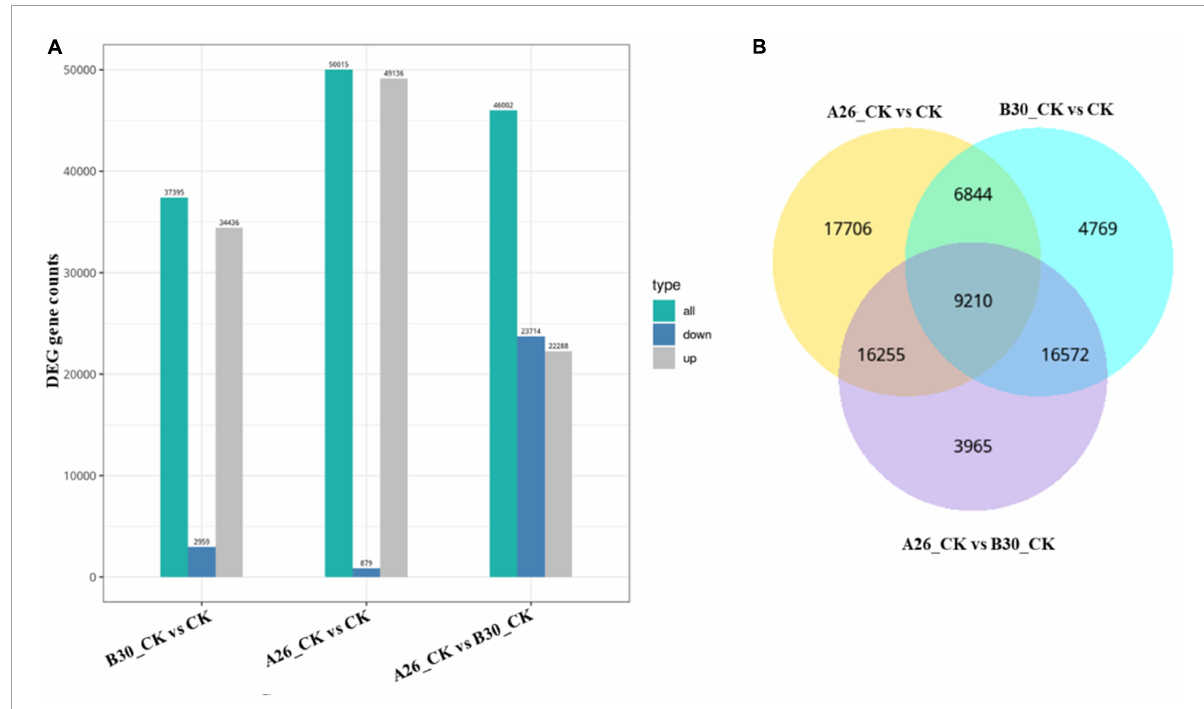
FIGURE9 (A) Bar graph showing differential expressed genes between the different group, (B) VENN mapping shows common DEGs between different